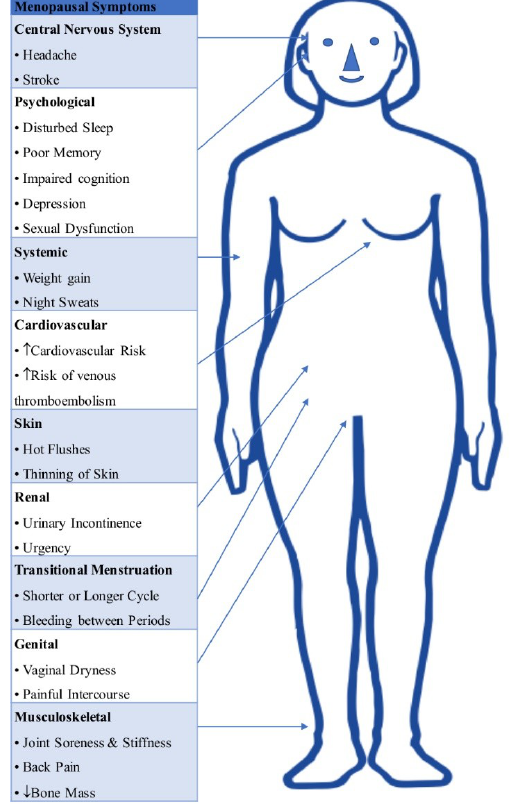
Figure 2. Schematic figure depicting various symptoms of menopause.